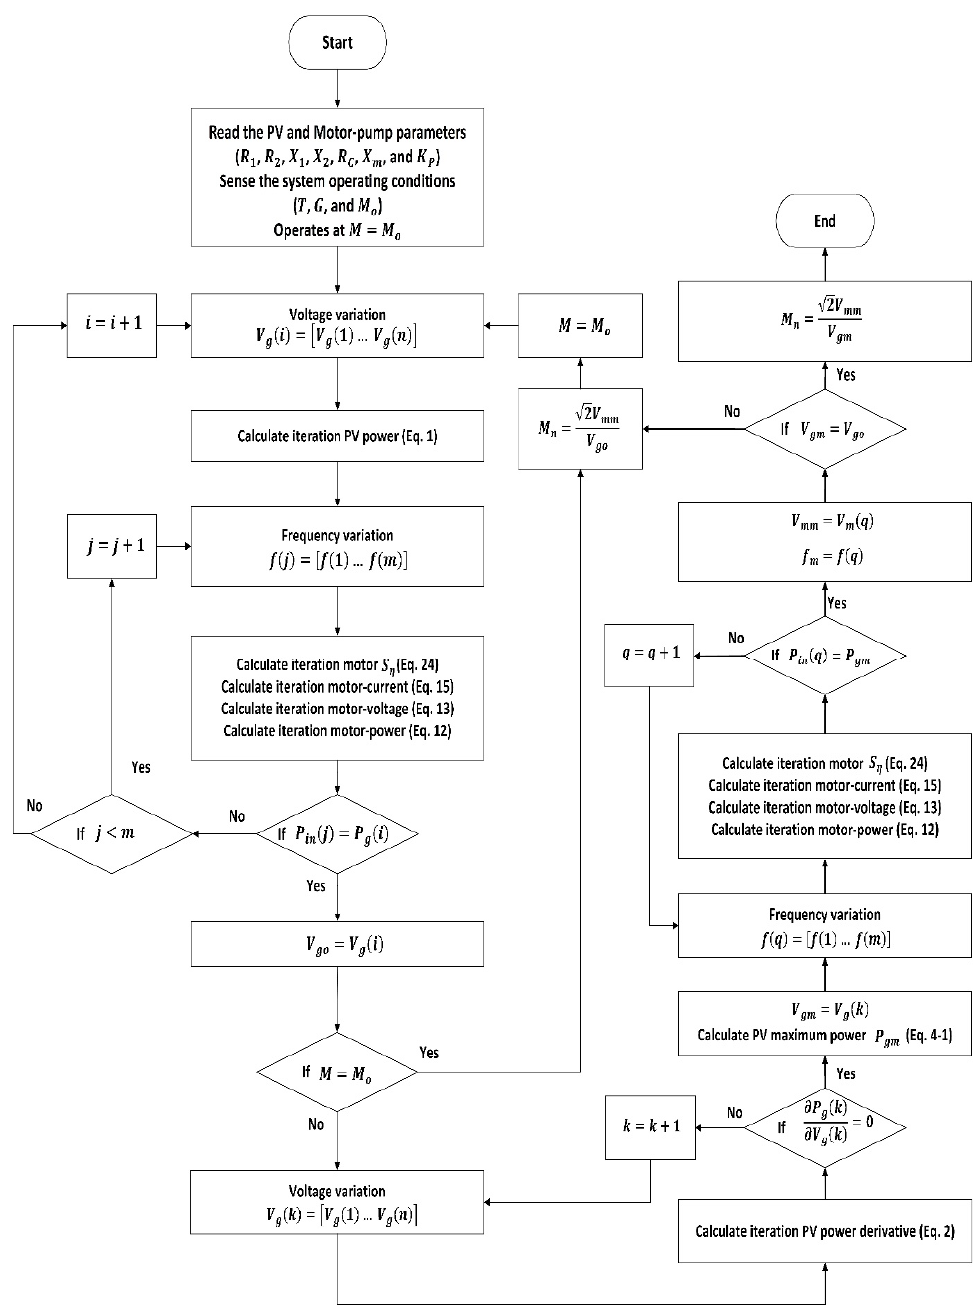
Figure 3. The proposed optimum operating technique’s calculation process.